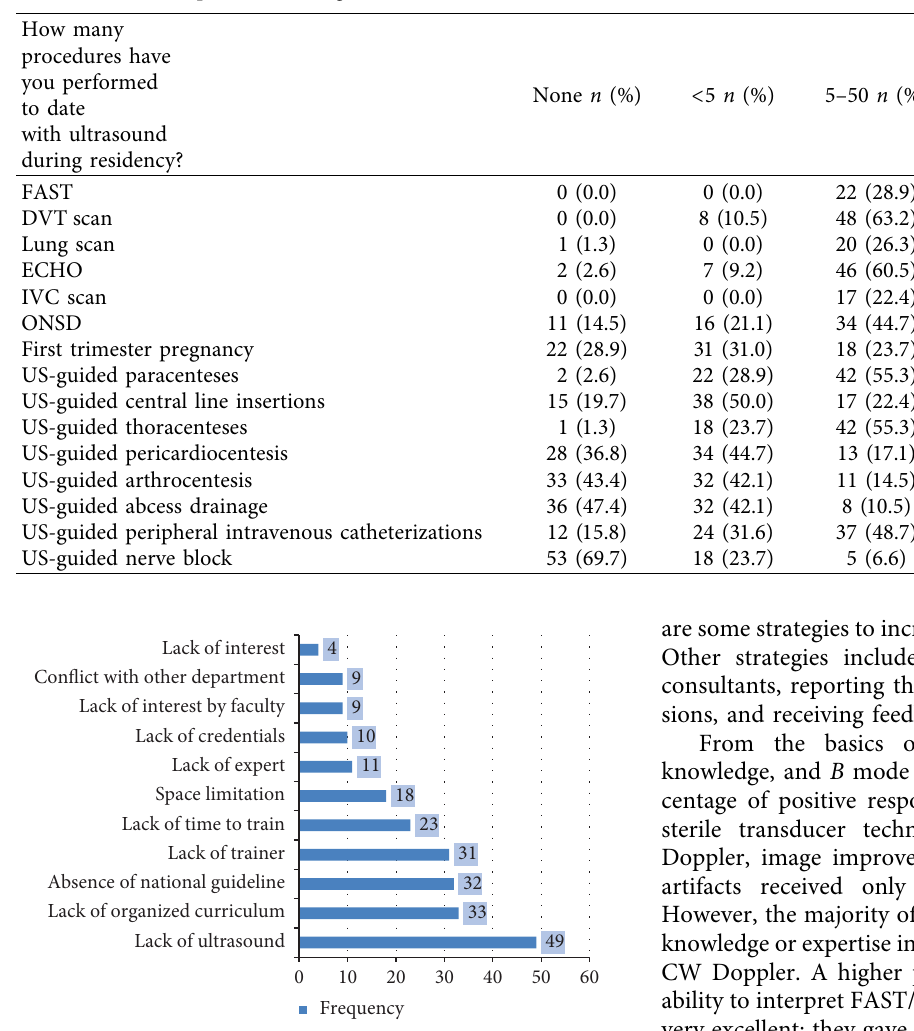
Table 3: Number of POCUS procedures performed by senior emergency medicine and critical care residents in SPHMMC and AAU/TASH,